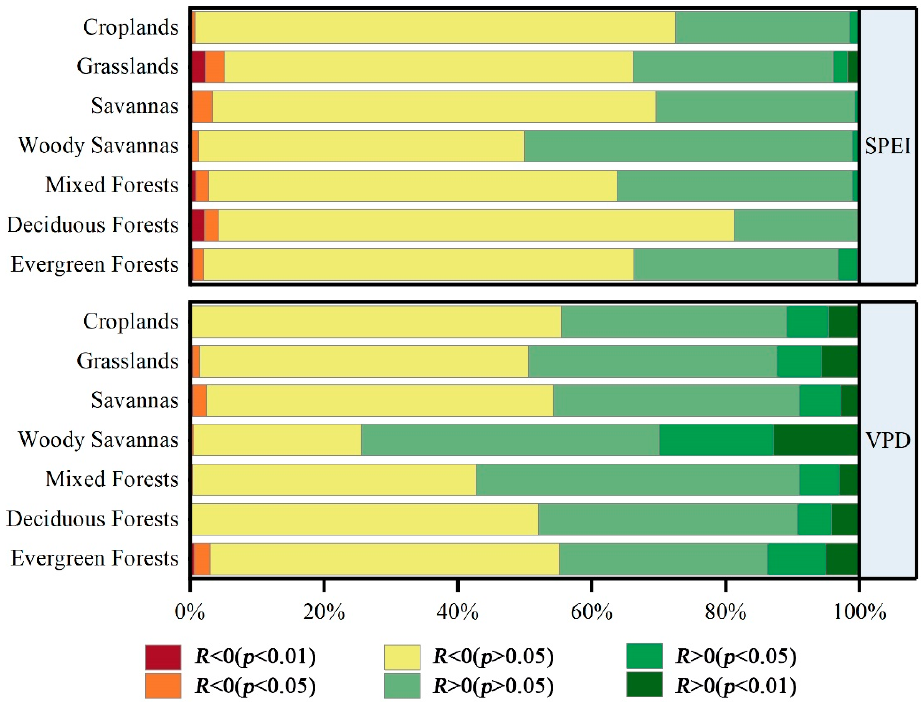
Figure 9. Spatial distribution of ( a ) the correlation coefficients ( R ) and ( b ) statistical signifi- cance ( p -value) between GPP drought_month (the average GPP of all drought months in a year) and SPEI drought_month (the sum of the absolute values of SPEI for all drought months in a year), and the spatial distribution of ( c ) the correlation coefficients ( R ) and ( d ) statistical significance ( p -value) between GPP drought_month and VPD drought_month (the sum of the values of VPD for all drought months in a year).